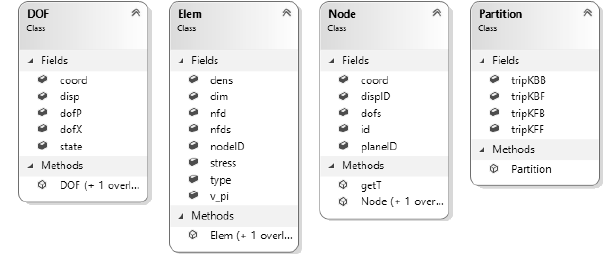
Figure 10: Class Diagram for numerical C++